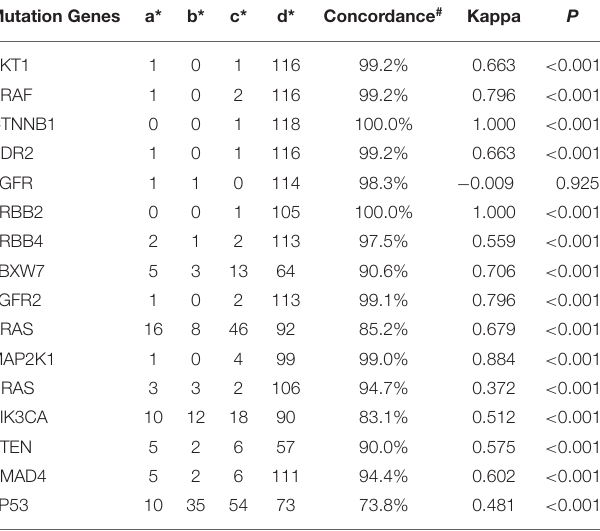
TABLE 4 | Comparison of fresh frozen and FFPE tissues in terms of variant characteristics. FFPE tissue